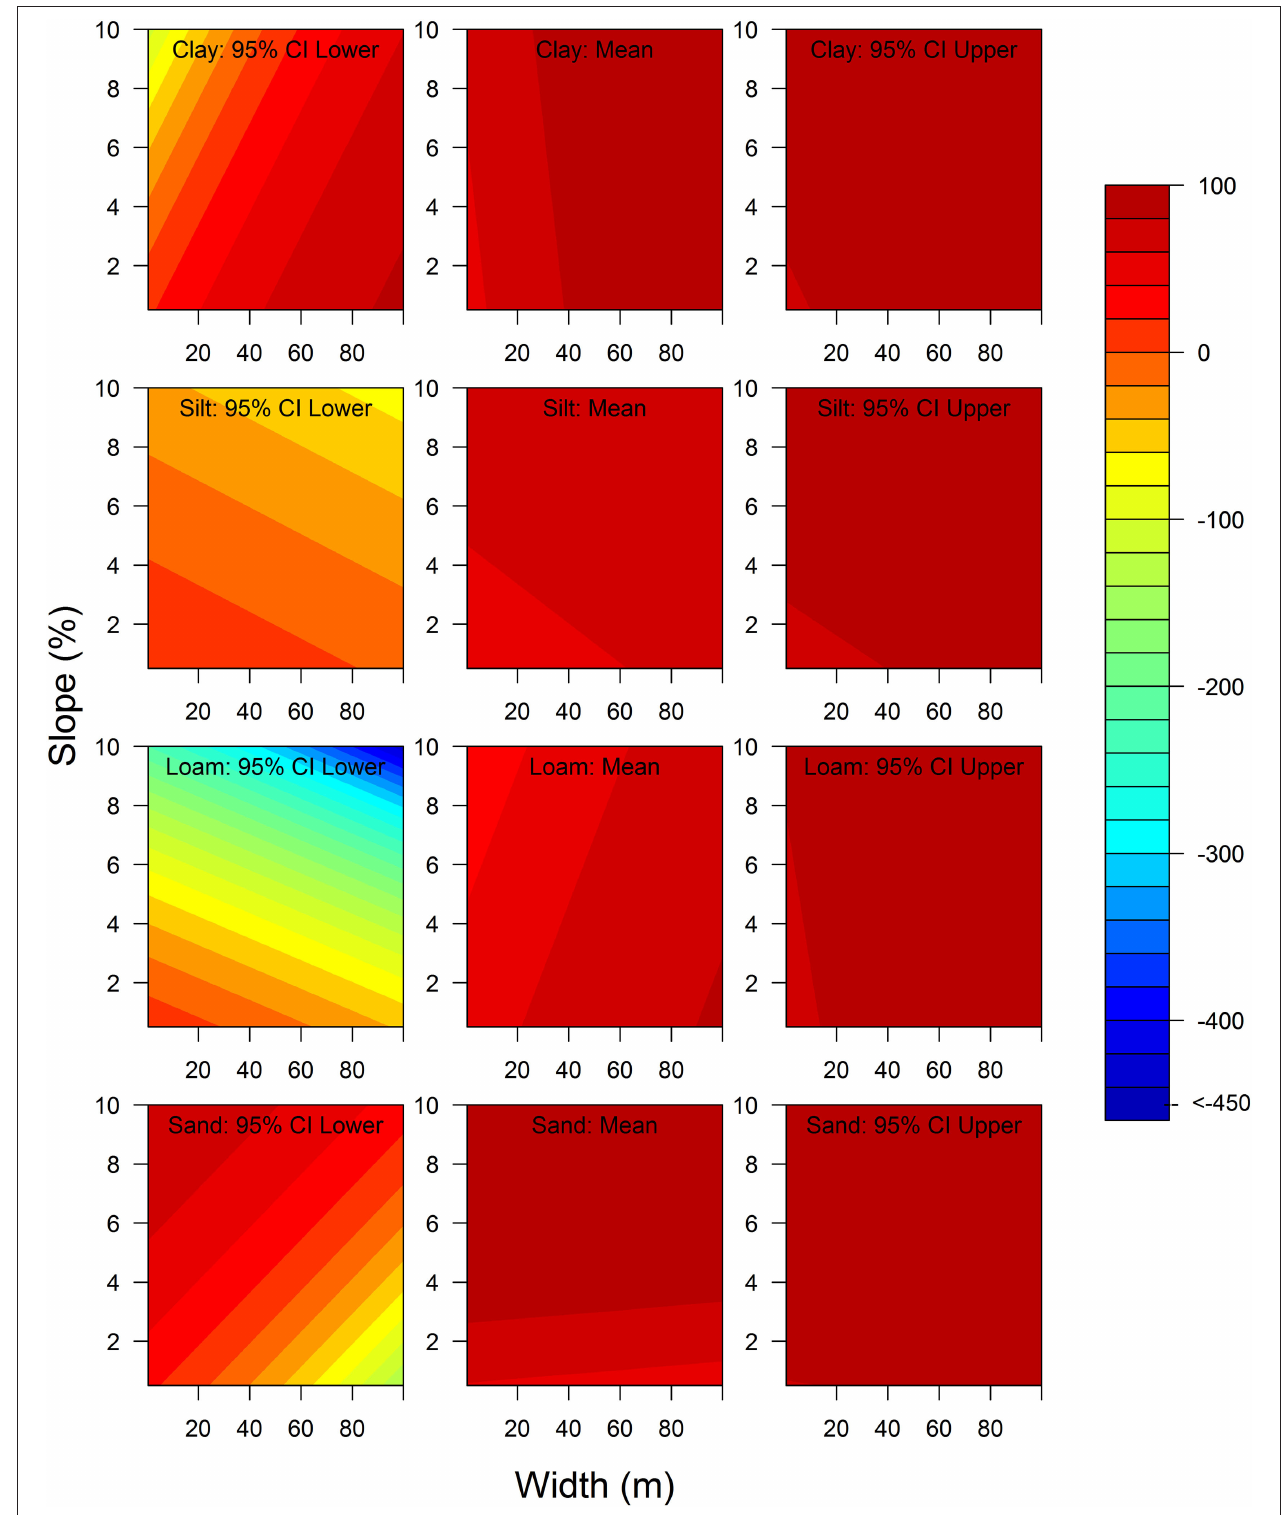
FIGURE 5 | The contours of P removal efficacy (mean and the 95% confidence interval) given RB width, slope, and soil type for the RBs installed adjacent to the fields with at least medium level of P application.